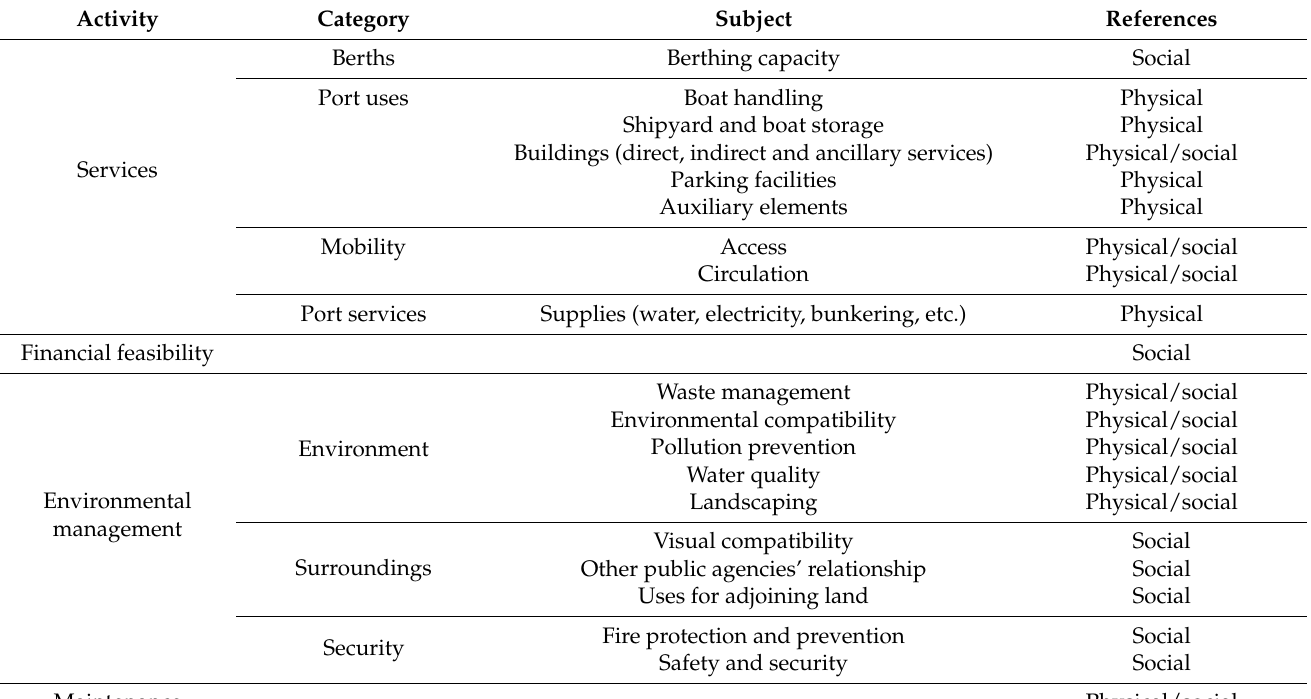
Table 3. Marina management’s literature